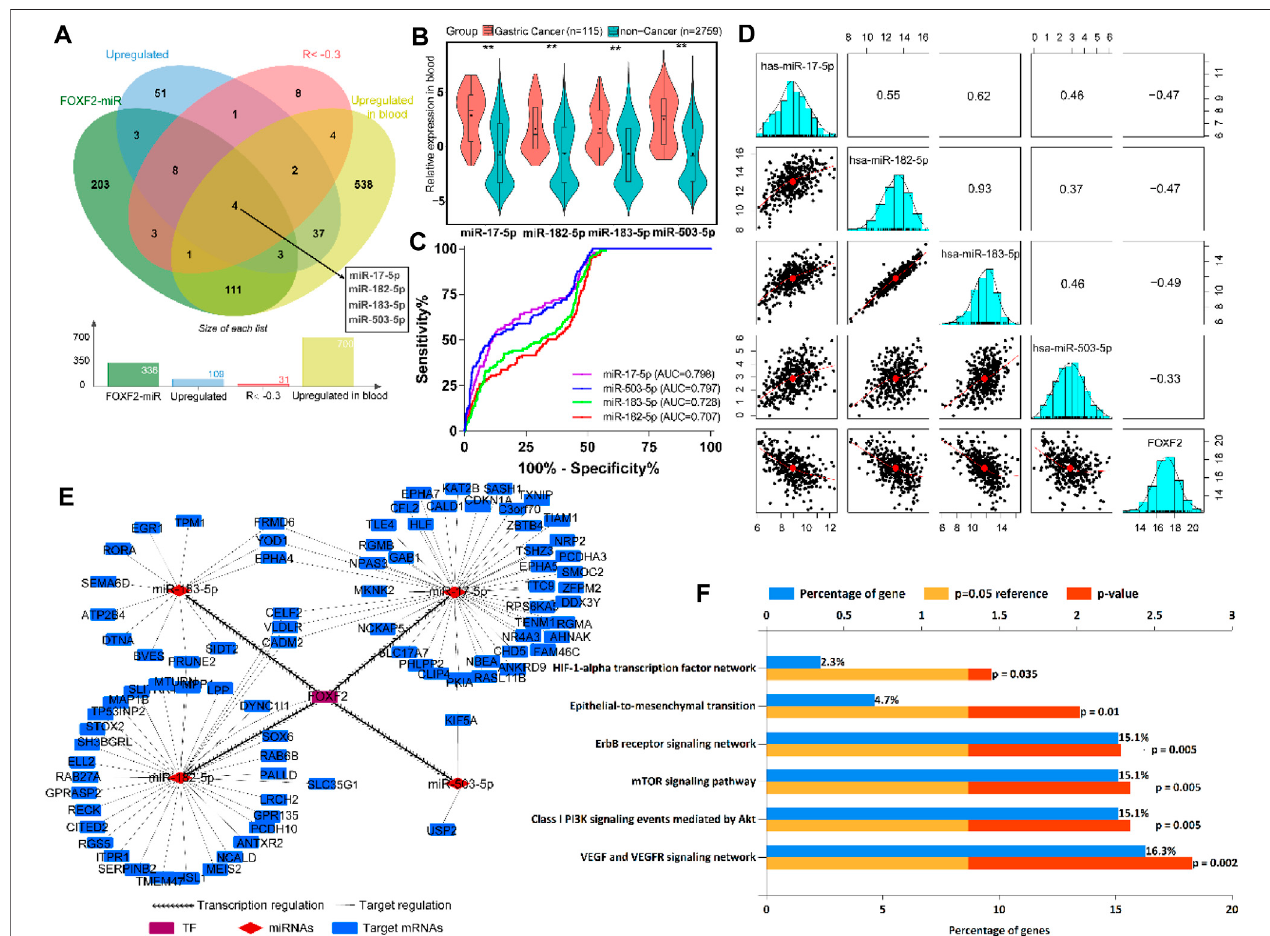
FIGURE 5 | FOXF2-miRNAs-target genes regulation network construction. (A) Four upregulated target miRNAs (miR-17-5p, miR-182-5p, miR-183-5p, and miR-503-5p) were identi fi ed to be transrepressed by FOXF2. (B) The four miRNAs are signi fi cantly upregulated in the blood of patients with GC than in normal people. (C) ROC analysis showed that the four miRNAs have preferable ability in distinguishing patients with GC from normal people, with AUC values of more than 0.7. (D) Pearson ’ s analysis showed that FOXF2 expression was signi fi cantly negatively correlated with miR-17-5p, miR-182-5p, miR-183-5p, and miR-503-5 expression. Values in the box represent Pearson R. (E) FOXF2-miRNAs-target genes regulation network showed that FOXF2 had a close regulation relationship with the miRNAs and the corresponding target genes. (F) Target genes functional enrichment analysis found that these genes are signi fi cantly related to HIF-1 α , ErbB, mTOR, epithelial-to-mesenchymal transition (EMT), Akt, VEGF, and VEGFR-mediated signaling pathway. * p < 0.05, ** p < 0.01, and *** p <